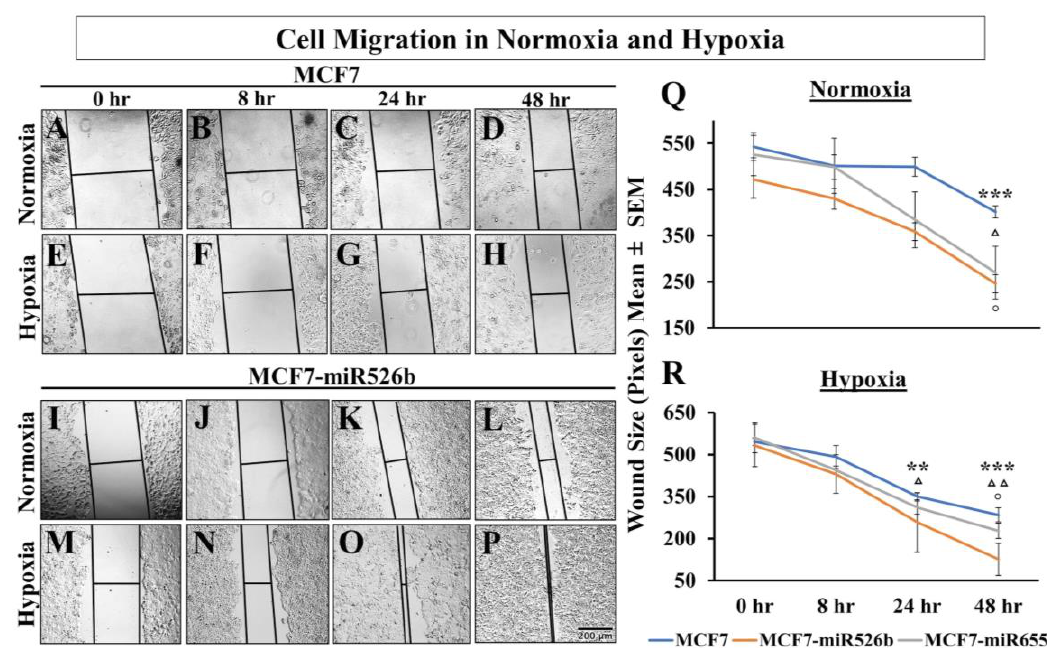
Figure 5. Cell migration in normoxia and hypoxia: baseline scratches represented by black lines at 0, 8, 24, and 48 h time points. Representative images of MCF7 are presented in ( A – D ) normoxia and ( E – H ) hypoxia. Representative images for MCF7-miR526b are presented in ( I – L ) normoxia and ( M – P ) hypoxia. Scale bar represents 200 µM. Wound size measured in pixels. ( Q ) Mean wound size in normoxic conditions over 0–48 h. ( R ) Mean wound size in hypoxic conditions over 0–48 h. Data are presented as the mean ± SEM of quadruplicate biological replicates; ** p < 0.01 and *** p < 0.001. * = MCF7, ◦ = MCF7-miR526b, ∆ = MCF7-miR655.